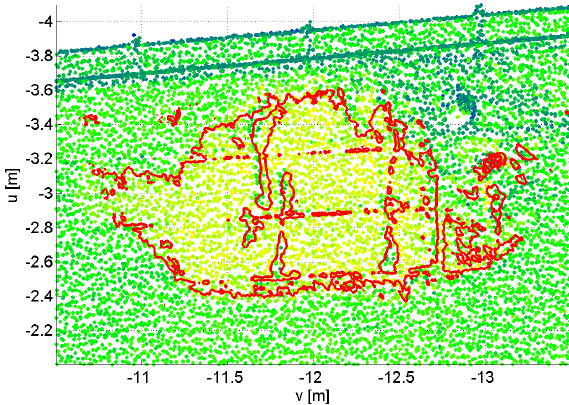
Figure 11: Example of segmentation results: a portion of the seg- mentation boundaries (red lines) for Fig. 1 remapped in the 3D space. Boundary lines are superimposed to the cloud points ac- quired by means of TLS. Observation direction is approximately orthogonal to the analyzed surface.